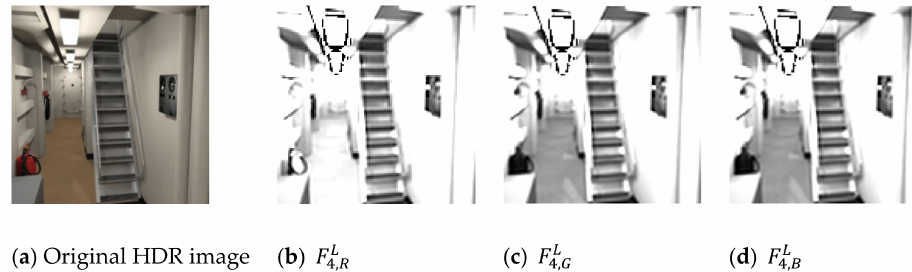
Figure 2. Low-pass sub-bands after four-level